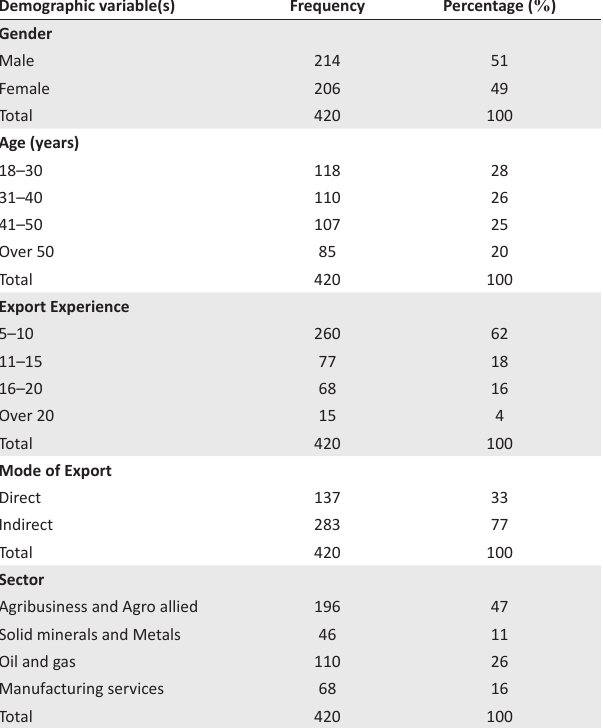
TABLE 1: Demographic distribution of the